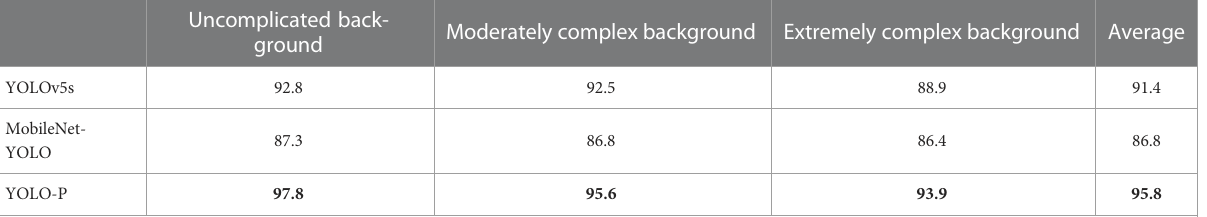
TABLE 8 F1 score (%) in different background complexities experiments during nighttime. Uncomplicated back- Moderately complex background Extremely complex background Average ground YOLOv5s